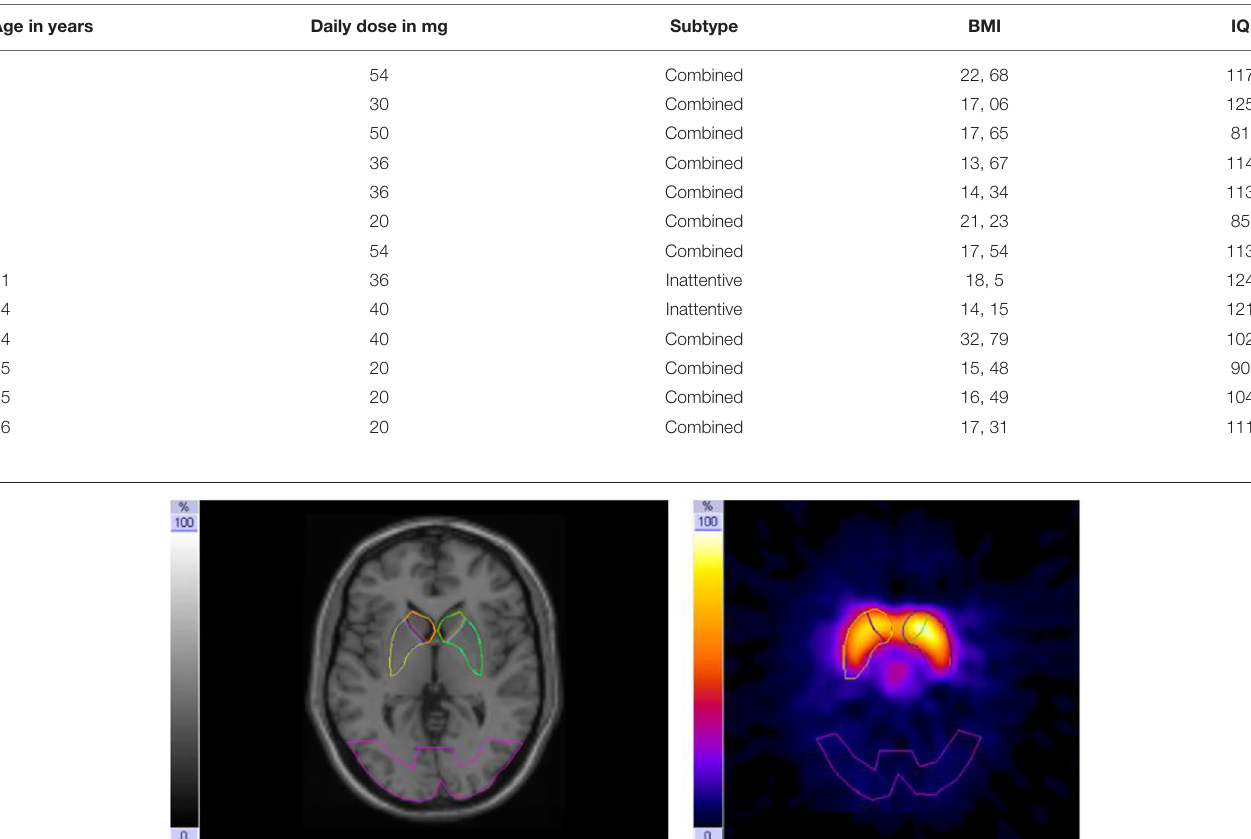
FIGURE 1 | Magnetic resonance imaging (MRI) with region of interest (ROI) template set covering the striatum with caudate nucleus and putamen and an occipital background ROI (left); I-123- β -CIT-SPECT [summation of the three consecutive slices with the highest tracer uptake in the basal ganglia